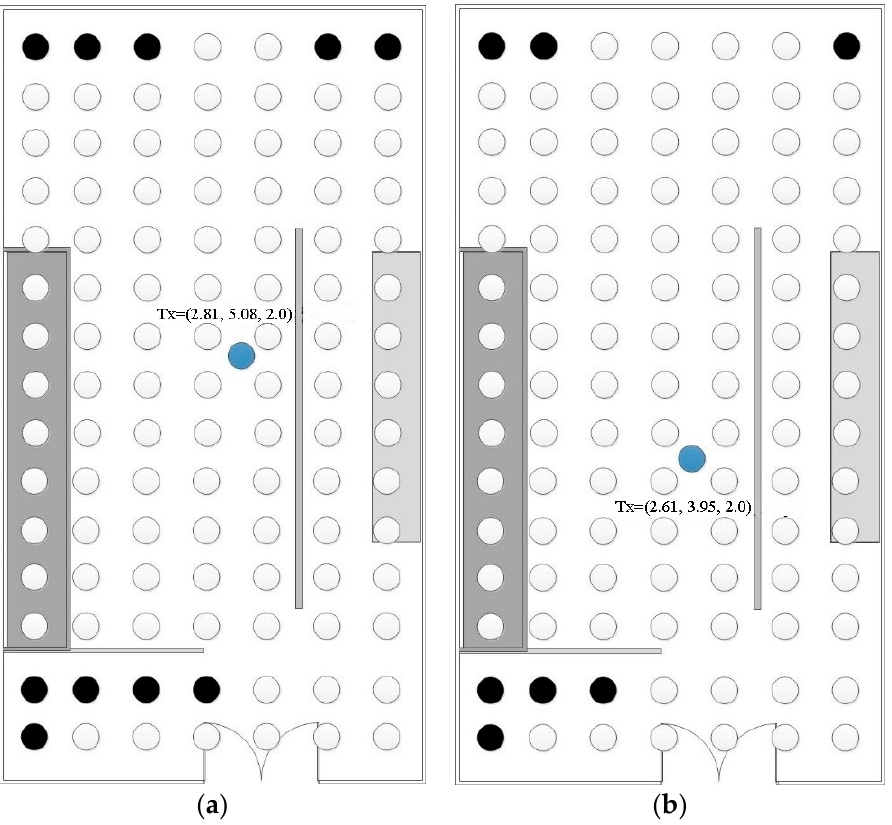
Figure 6. ( a ) The distribution of the outage points for the transmitter at (2.81, 5.08, 2.0) m by self- adaptive dynamic differential evolution (SADDE); ( b ) The distribution of the outage points for the transmitter at (2.61, 3.95, 2.0) m by asynchronous particle swarm optimization (APSO). Table 2. Performance comparison for SADDE and APSO.